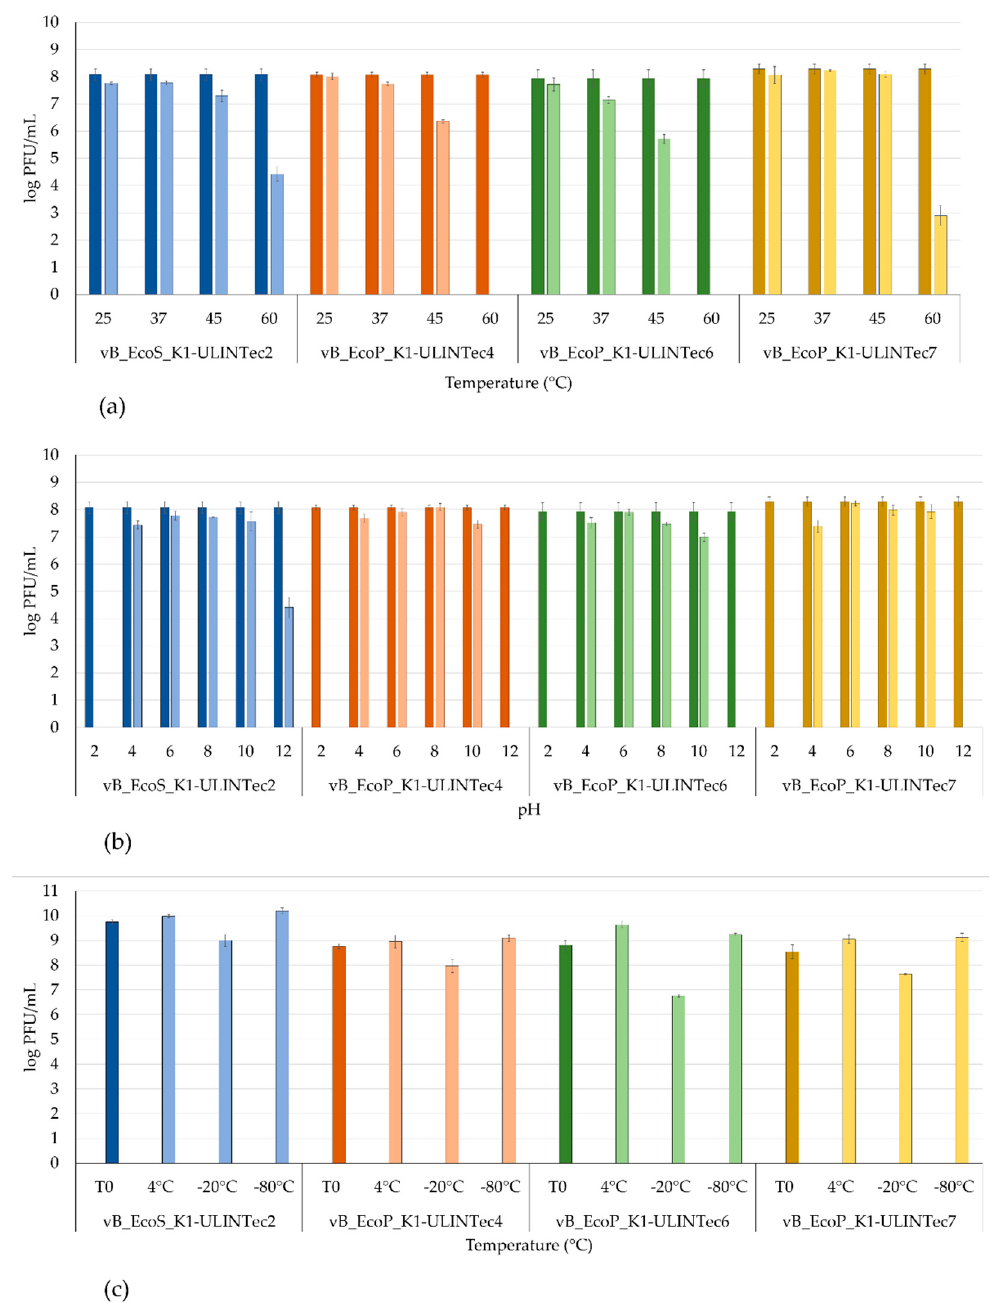
Figure 8. Temperature ( a ), pH ( b ), and storage ( c ) stability results of phages vB_EcoS_K1-ULINTec2, vB_EcoP_K1-ULINTec4, vB_EcoP_K1-ULINTec6, and vB_EcoP_K1-ULINTec7. The results are the mean value of three titrations. Dark bars represent the concentration measured before testing.